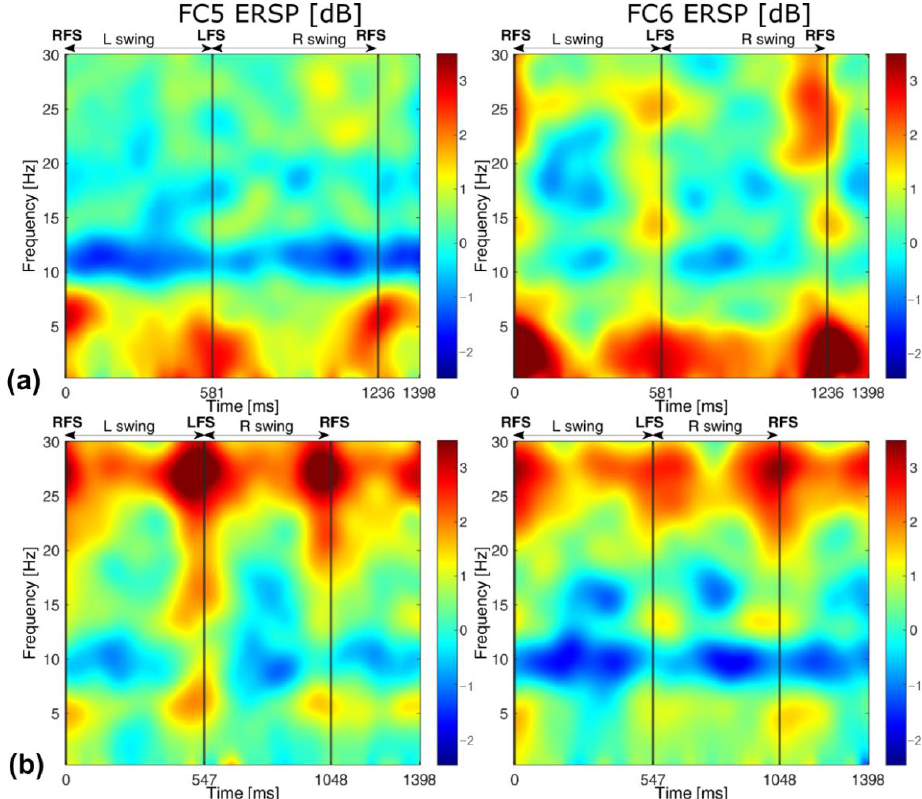
Figure 5. ERSP maps locked to the gait cycle for the electrodes FC5 (left hemisphere) and FC6 (right hemisphere) of the child with CP (CP01) ( a ) and HC ( b ). RFS: Right Foot Strike; LFS: Left Foot Strike; L swing: Left foot swing phase; R swing: Right foot swing phase.